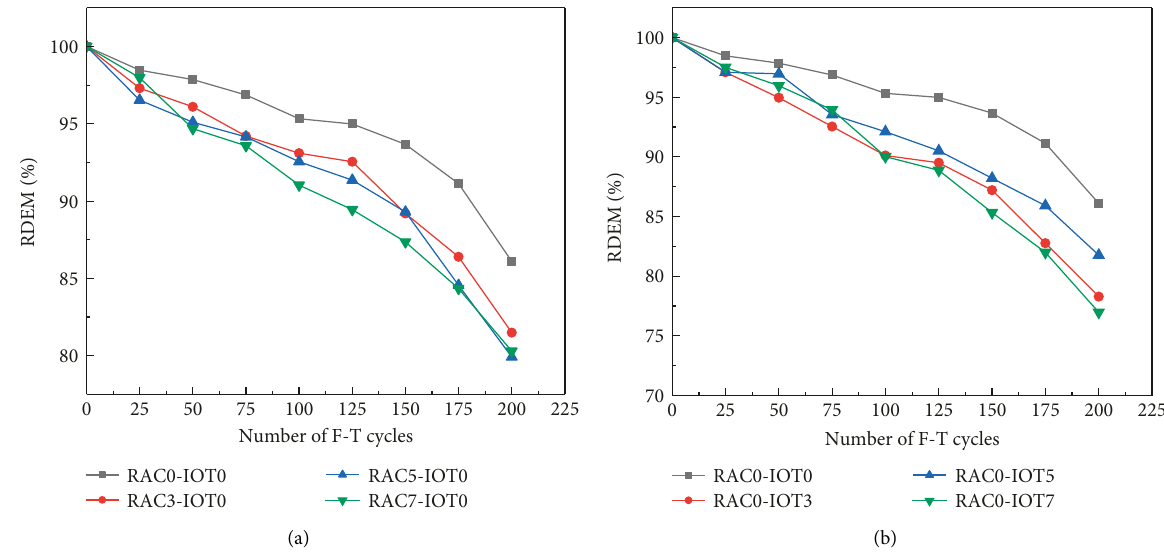
Figure 9: Change rate of RDEM of iron ore tailings recycled aggregate concrete during F-T cycle: (a) the replacement rate of IOT is 0%; (b) the replacement rate of RCA is